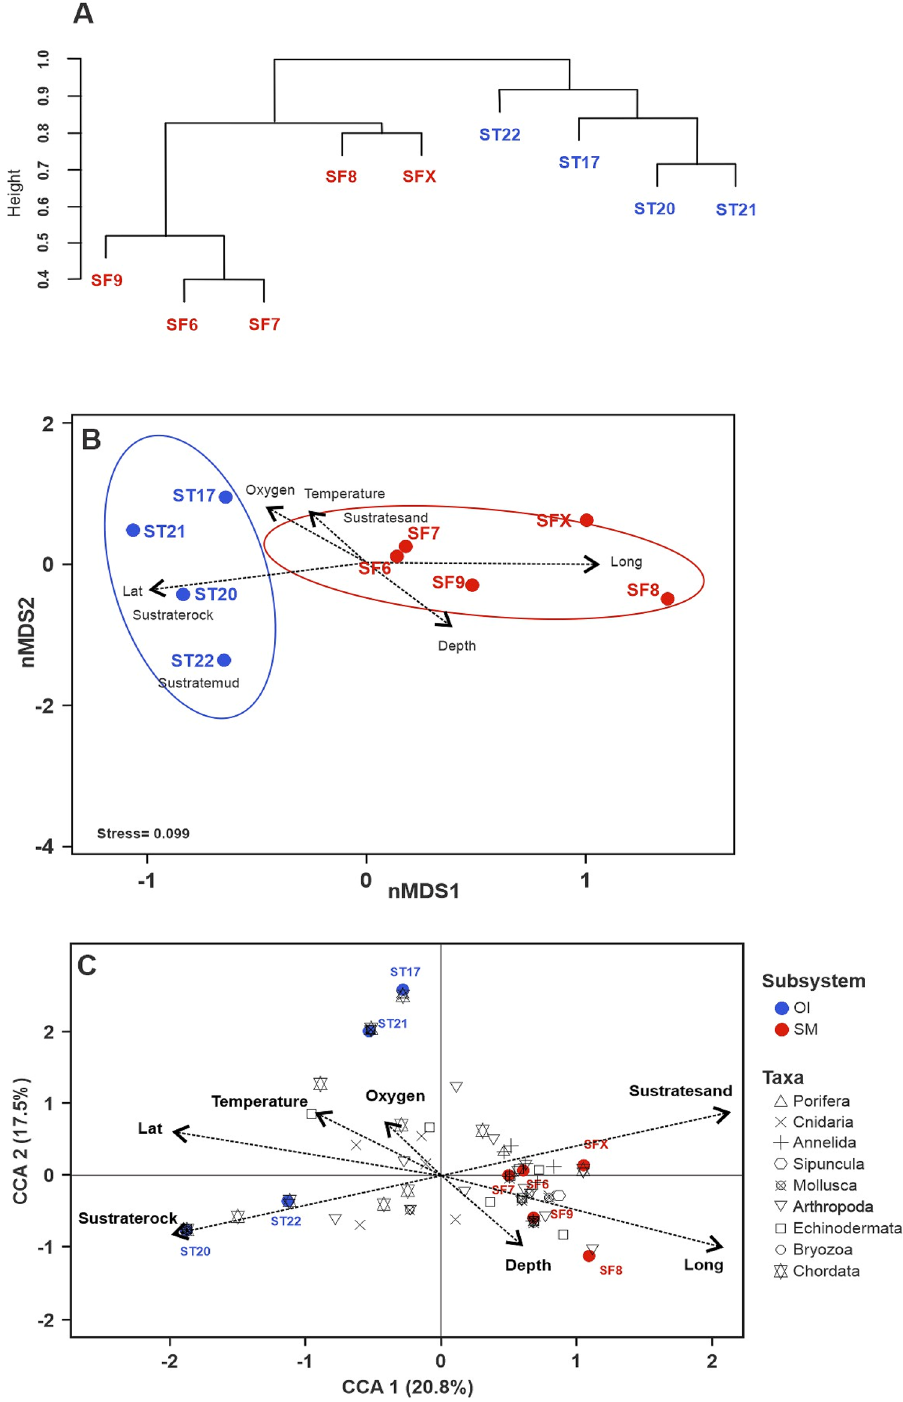
Figure 5. ( A ) Cluster analysis (UPGMA method) based on Bray–Curtis dissimilarity, ( B ) non-metric multidimensional scaling (nMDS) ordination plot based on presence/absence data of the benthic megafauna, and ( C ) canonical correspondence (CCA). Analysis based on the community structure of benthic megafauna, grouped at major taxa level, from stations sampled at Desventuradas Islands (blue markers) and seamounts (red markers) of the Nazca Desventuradas Marine Park. Vectors in ( B ) and ( C ) represent contribution of environmental descriptors (salinity, oxygen, temperature, substrate type, depth, latitude and longitude), and ellipses in ( B ) represent the 95% confidence interval. Image generated using R software (version 4.0.3) 47